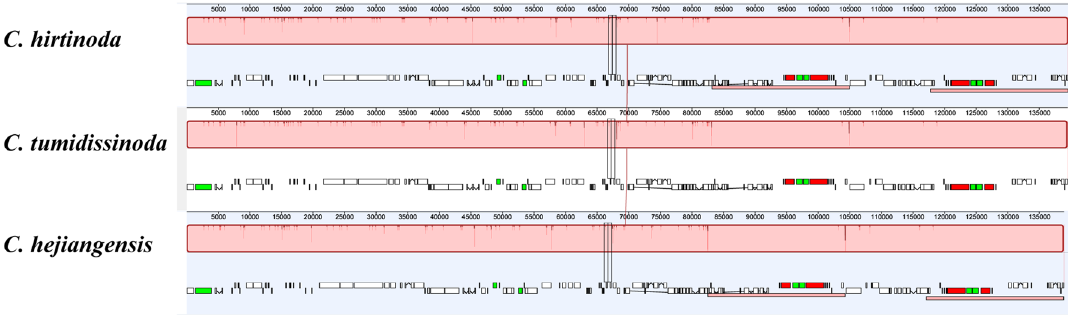
Figure 8. The chloroplast genomes of three Chimonobambusa species rearranged by the software MAUVE. Locally collinear blocks (LCBs) are represented by the same color blocks connected by lines. The vertical line indicates the degree of conservatism among position. The small red bar represents